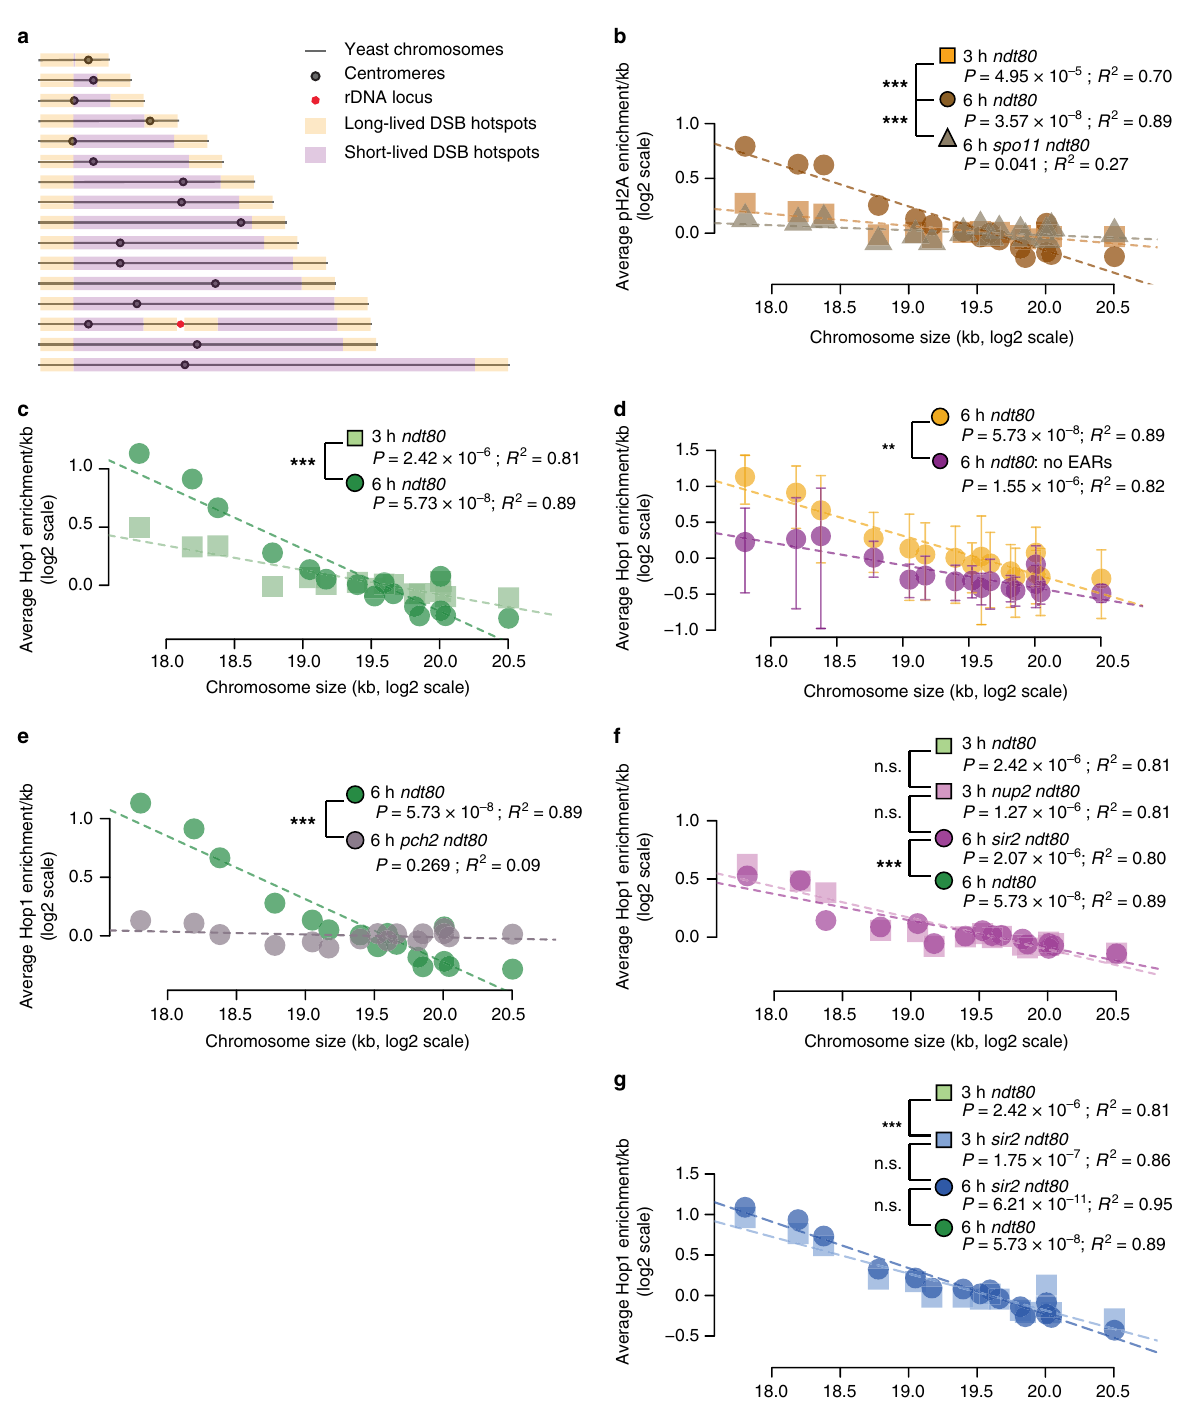
Fig. 8 Enrichment of Hop1 and DSB markers on short chromosomes increases signi fi cantly in late prophase. a Schematic of telomere-adjacent enrichment of Hop1 in late prophase predicts bias for DSBs on short chromosomes. The orange bars illustrate the large domains (~100kb) of long-lived DSB hotspots at telomere-adjacent and rDNA-adjacent regions. Interstitial regions (magenta) harbor mainly the short-lived DSB hotspots. b – g Mean ChIP-seq enrichment per kb is plotted for each chromosome on log scale with regression analysis. P and R 2 values are noted below the sample name. R 2 , measure of the fi t of the points to the line, can vary from 0 to 1.0 with 1.0 indicating a perfect fi t. P is the probability of obtaining large R 2 values. Two-way ANOVA was performed to test signi fi cant difference in the slope between the regression lines for different ChIP-seq samples. ANOVA-derived P values are indicated, *** P <0.001. γ -H2A ChIP-seq enrichment in early ( T = 3h) and late prophase ( T = 6h) in ndt80 Δ and late prophase ( T = 6h) in spo11 Δ ndt80 Δ in b . Hop1 ChIP-seq in early ( T = 3h) and late prophase ( T = 6h) in ndt80 Δ samples ( c ). Hop1 ChIP-seq in late prophase from ndt80 Δ samples ( T = 6h) is plotted in orange ( d ). Plot in magenta is Hop1 enrichment from telomere-distal regions lacking EARs (110kb from each chromosome end). Error bars are standard deviation of the means of 10 equal sized bins for each chromosome. Late prophase ( T = 6h) enrichment of Hop1 in ndt80 Δ and pch2 Δ ndt80 Δ cultures ( e ). Hop1 ChIP-seq in early (3h) and late prophase ( T = 6h) in nup2 Δ ndt80 Δ samples ( f ). Hop1 ChIP-seq in early ( T = 3h) and late prophase ( T = 6h) in sir2 Δ ndt80 Δ samples ( g